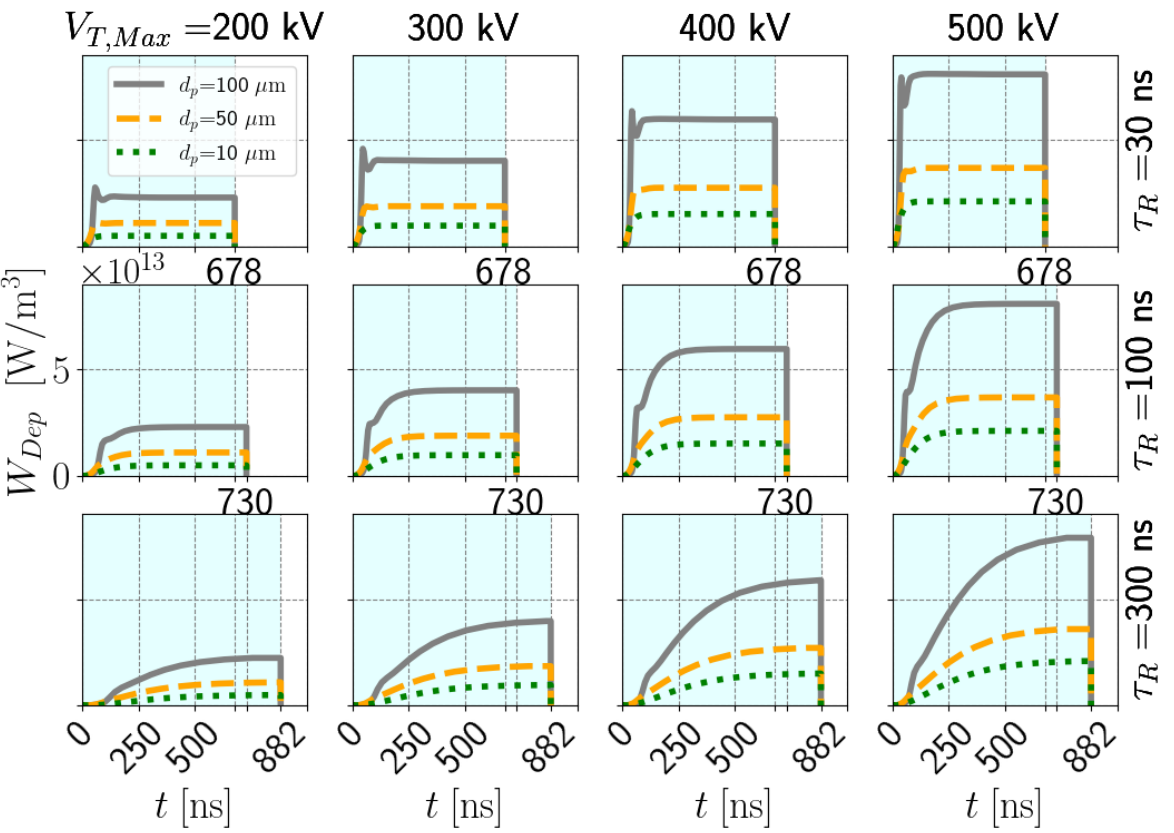
Figure 7. The deposited electric power density in a single pore, W Dep , versus time, t , for the three pore widths, d P , investigated. The cyan area represents the plasma discharge time, which varies with the pulse rise time. The four columns represent four values of the maximum pulse voltage drop, V T , Max , and the three rows represent three values of the pulse rise time, τ R